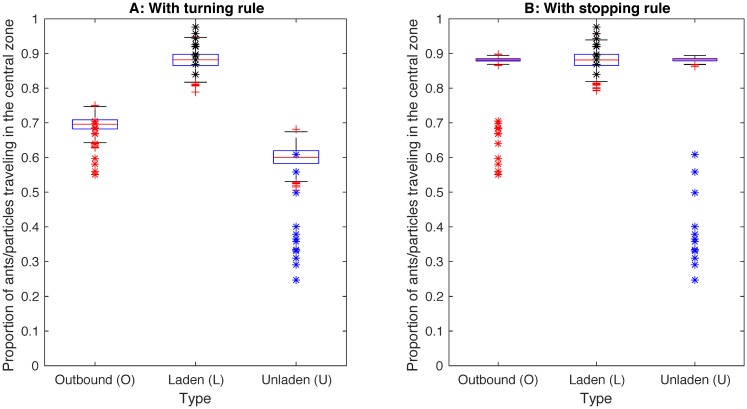
Comparison model-experiment for the wide trail.The asterisks represent the proportion of ants of the specific type traveling in the central zone on the trail in the experiments. The boxes represent corresponding measurements over 1000 simulations (red crosses represents outliers) of (A) The wide trail model with the turning rule, and (B) The wide trail model with the stopping rule instead of the turning rule.